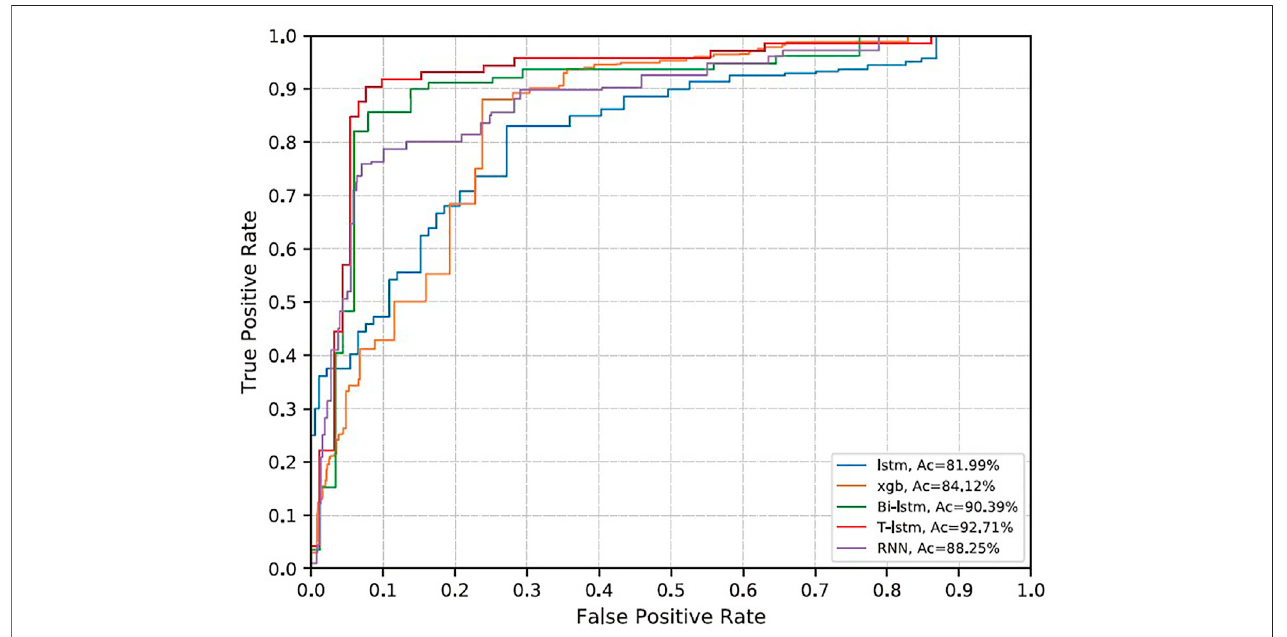
FIGURE 8 | ROC curve of each model. Blue is LSTM; orange is gradient boost (xgb); green is BiLSTM; red is T-LSTM; and purple is